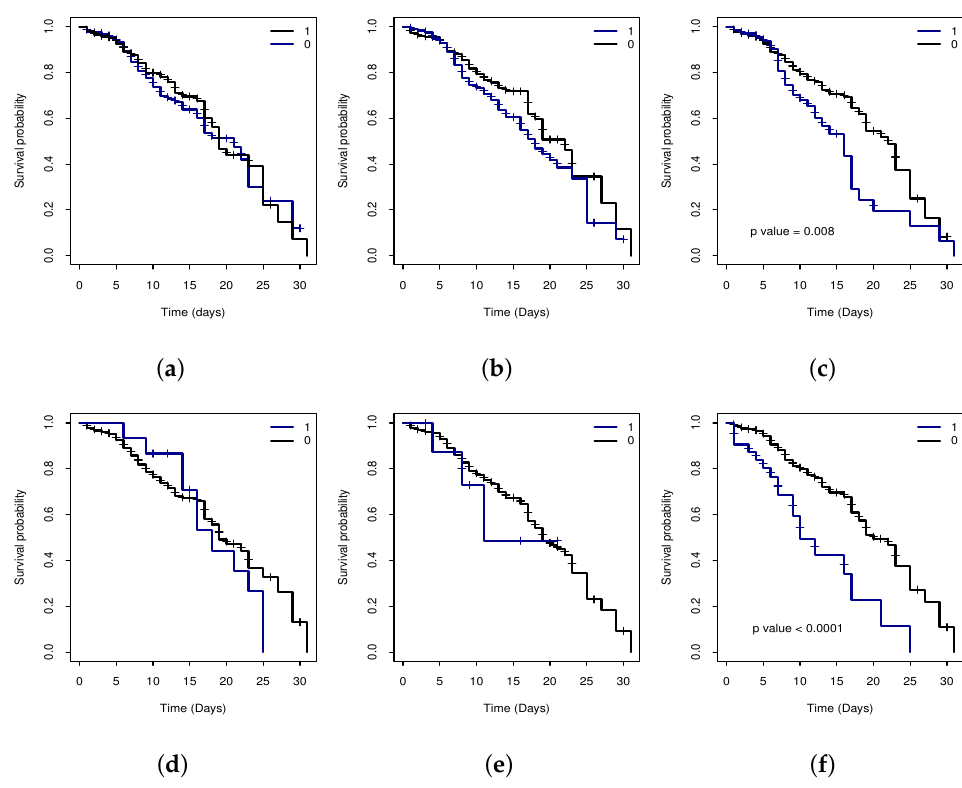
Figure 4. Kaplan–Meier survival curves: ( a ) Sex; ( b ) Chronic cardiovascular disease; ( c ) Diabetes mellitus; ( d ) Obesity; ( e ) Asthma and ( f ) Chronic neurological